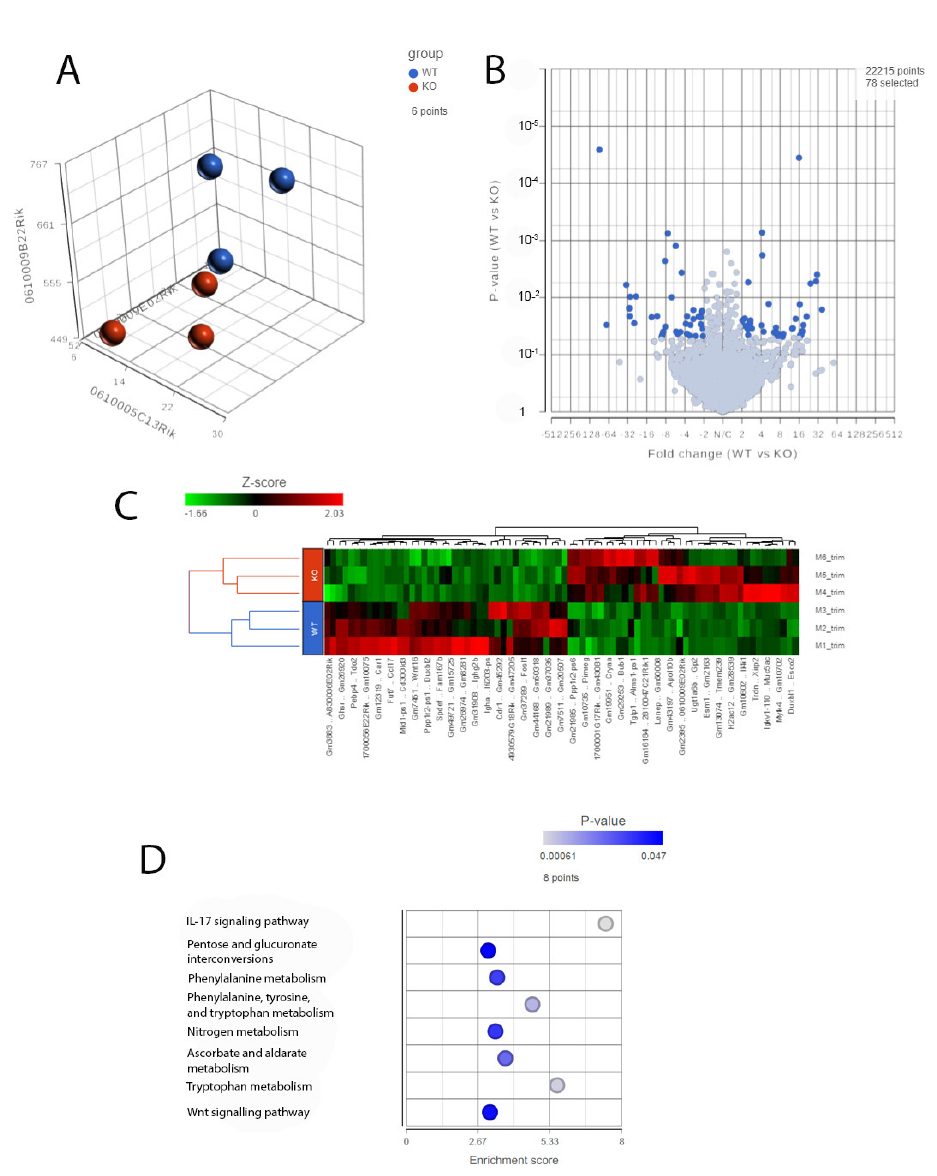
Figure 7. RNA-Seq analysis of 1-year-old wild-type and KO mice. ( A ). PCA plots of RNA-Seq data showing the characteristics of the overall gene expression of each sample. ( B ). Volcano plot showing expression changes between the wild-type and KO mice. ( C ). Heat map displaying the expression profile of the top differentially expressed genes. ( D ). GO pathway enrichment in the KO mice compared with the wild-type mice (adjusted p < 0.05).